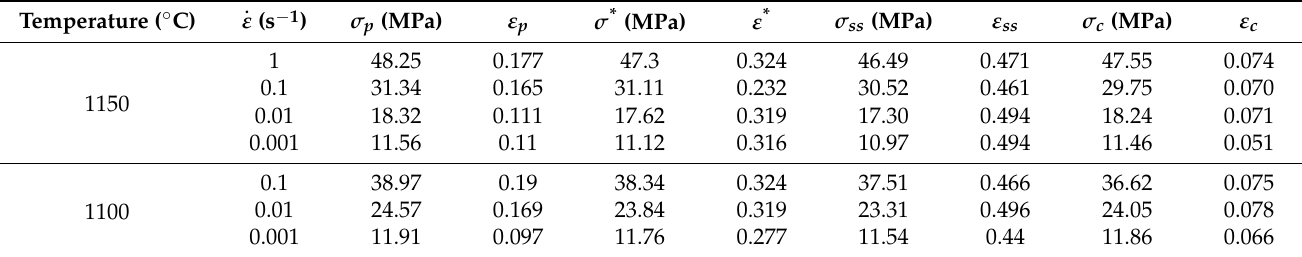
Figure 4. θ vs. 𝜎 plots for Fe-Cr-Al-La stainless steel at strain rates of ( a ) 0.1 s −1 , ( b ) 0.01 s −1 and ( c ) Figure 4. θ vs. σ plots for Fe-Cr-Al-La stainless steel at strain rates of ( a ) 0.1 s − 1 , ( b ) 0.01 s − 1 and 0.001 s −1 . ( c ) 0.001 s − 1 . Table 2. Values of DRX characteristic parameters at different deformation conditions. Table 2. Values of DRX characteristic parameters at different deformation